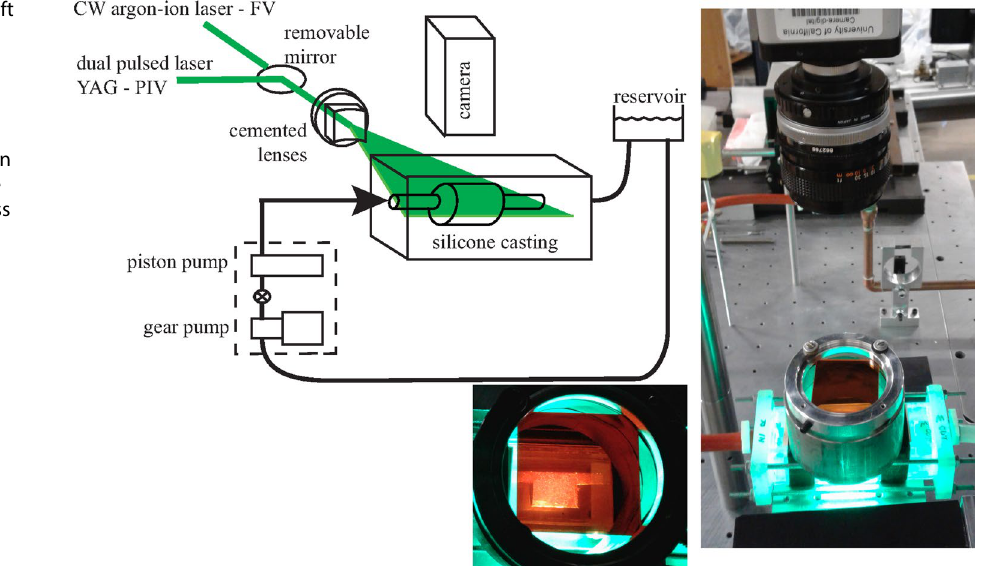
Fig. 1 Experimental setup. Left top: sketch of the flow loop and the experimental setup for recording the flow field. Right: picture of the camera positioned above the cavity. Left bottom: the cavity as seen with the naked eye under the laser light through a high-pass filter